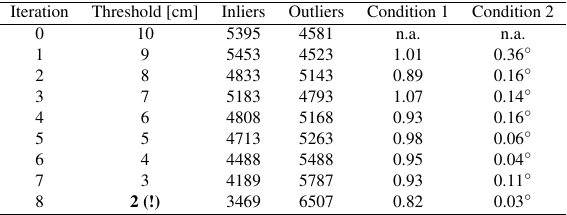
Table 1: Iterations of the RANSAC ceiling plane fitting step for the 3D model of a room.